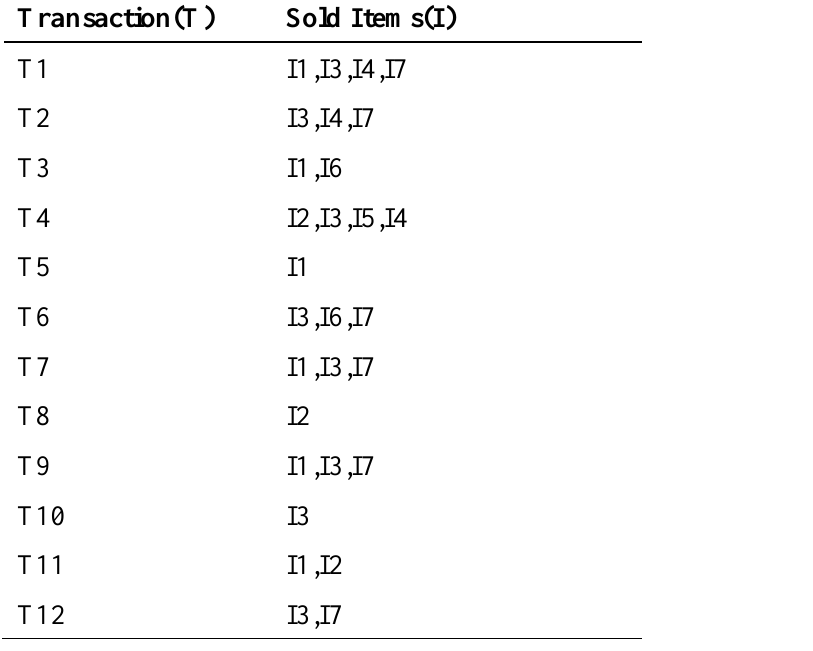
Table 1. Table of Transactions With Useless